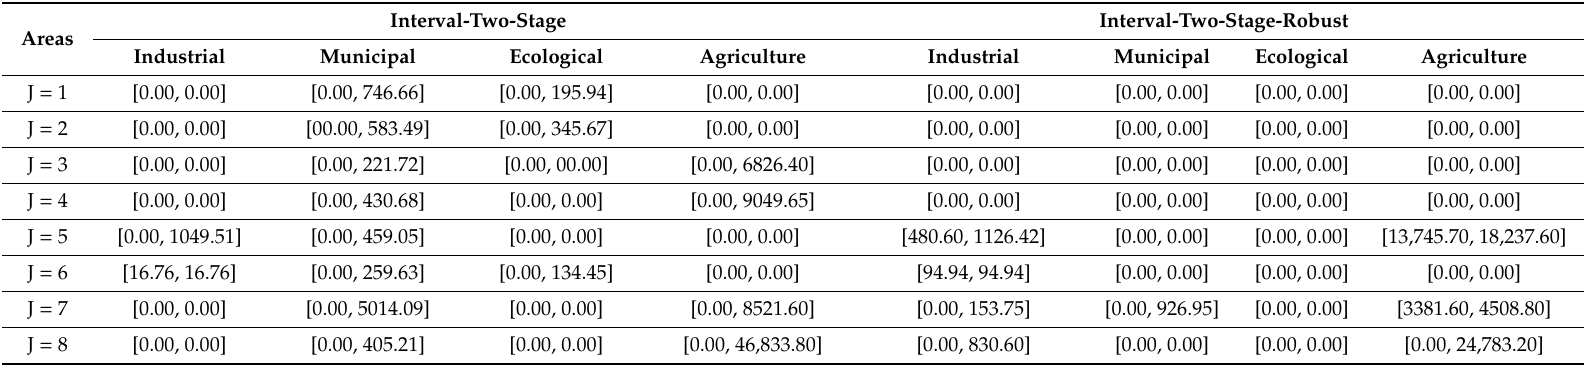
Table 8. Water shortage of ITSP model and ITSR model in di ff erent water use departments under medium levels of available water resources in the first planning period (10 4 m 3 /